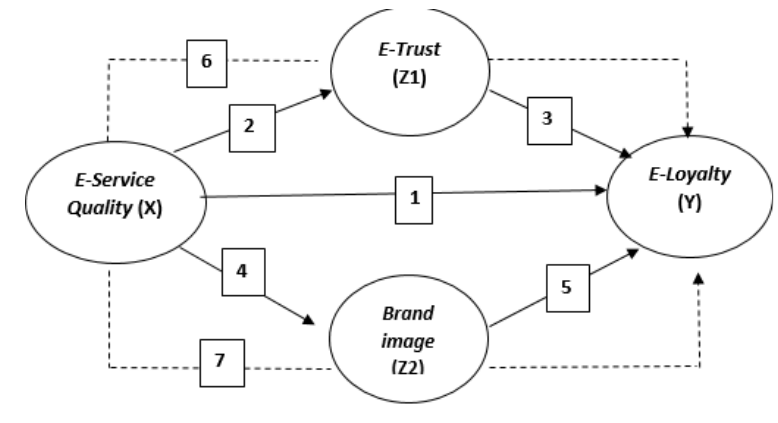
Figure 1: Research Framework and